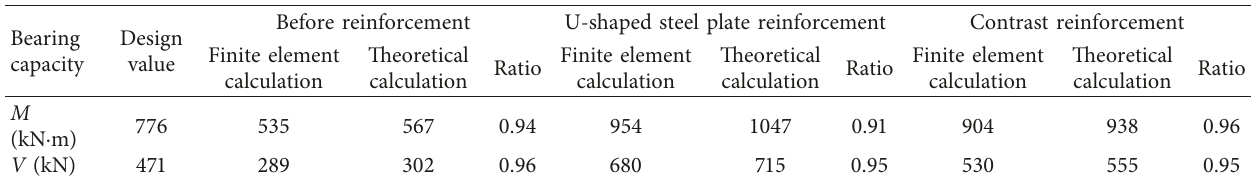
Figure 11: Peak stress field of the U-shaped steel plate reinforcement curve. Stress field of (a) reinforcement skeleton, (b) concrete, and (c) U-shaped steel plate. Table 2: Review and comparison of bearing